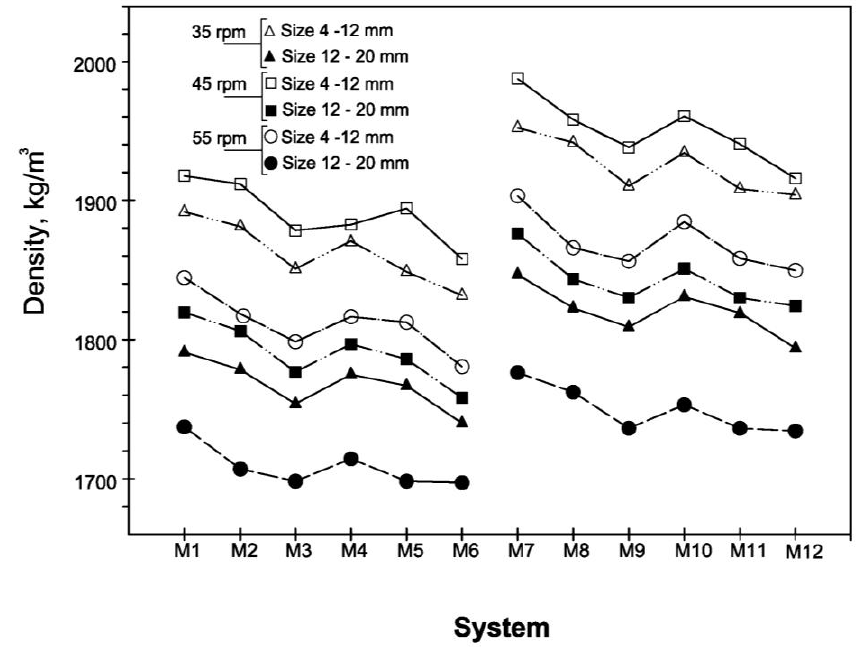
Figure 6. Dry density values of the artificial aggregates after 56 days